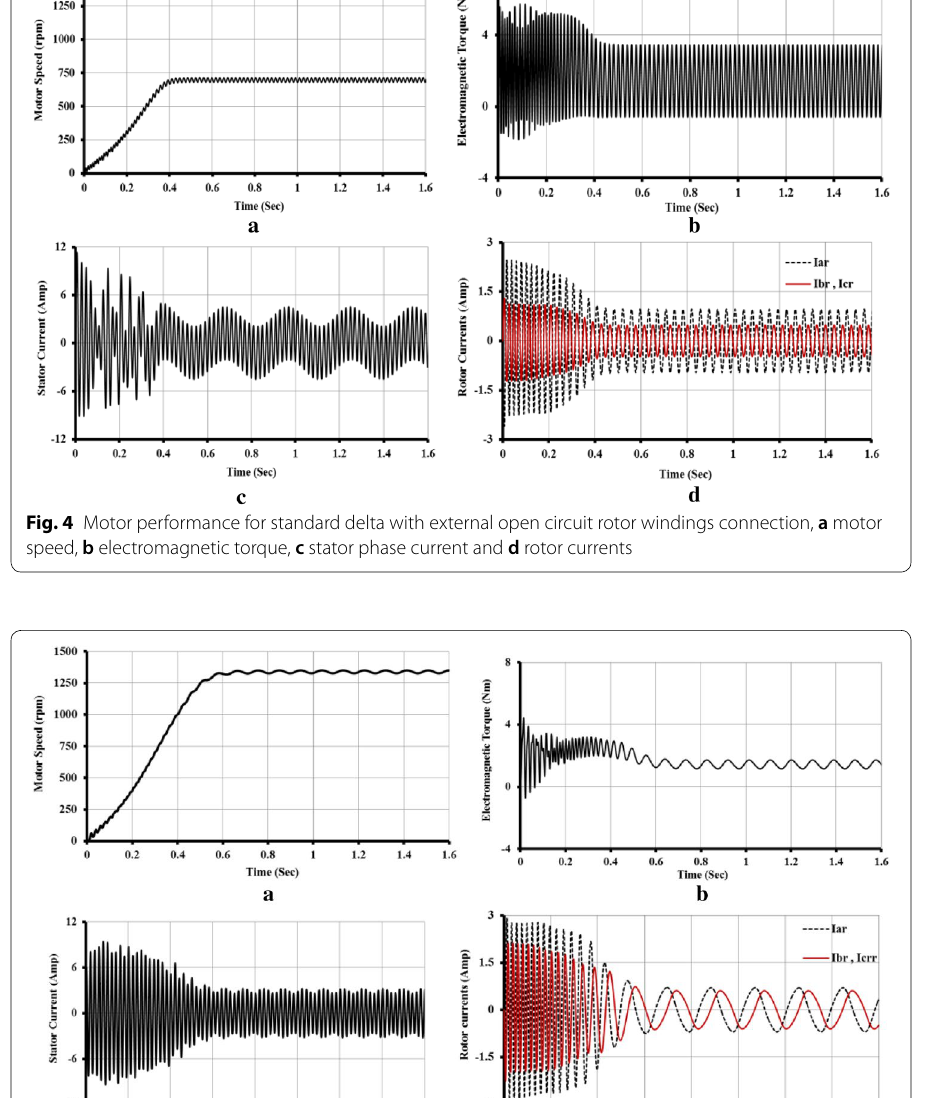
phase “cr” of the rotor are the same since they are connected in series, while the current of phase “ar” is shifted by 90 electric degrees from the other two phases as shown in Fig. 5d.